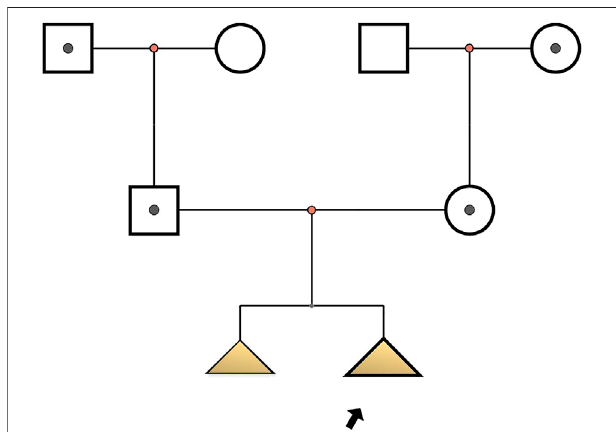
FIGURE 1 | Pedigree of osteogenesis imperfecta IX-affected family. Arrow indicates the proband ( Ⅲ 2): c.509G > A in PPIB homozygote; I1, I4, II1, II2: c.509G > A heterozygote; Ⅲ 1: with similar phenotype but no genetic